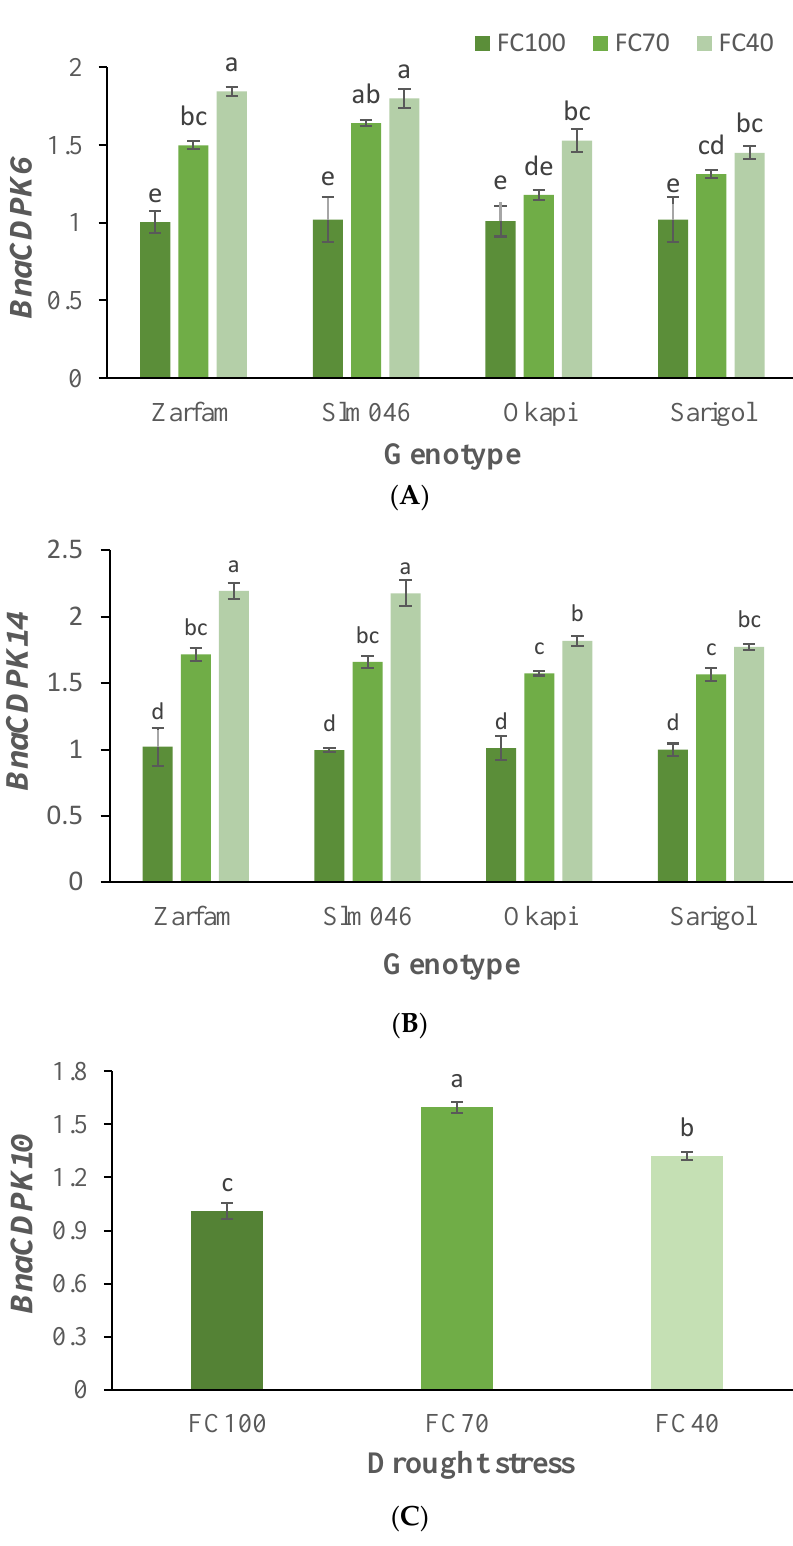
Figure 7. Effects of drought stress and genotype on BnaCDPK6 ( A ), BnaCDPK14 ( B ) and BnaCDPK10 ( C ) transcript accumulation in canola leaves. Data are means ( n = 3) ± SE. Different letters indicate differences ( p < 0.05) among treatments according to the Duncan test.